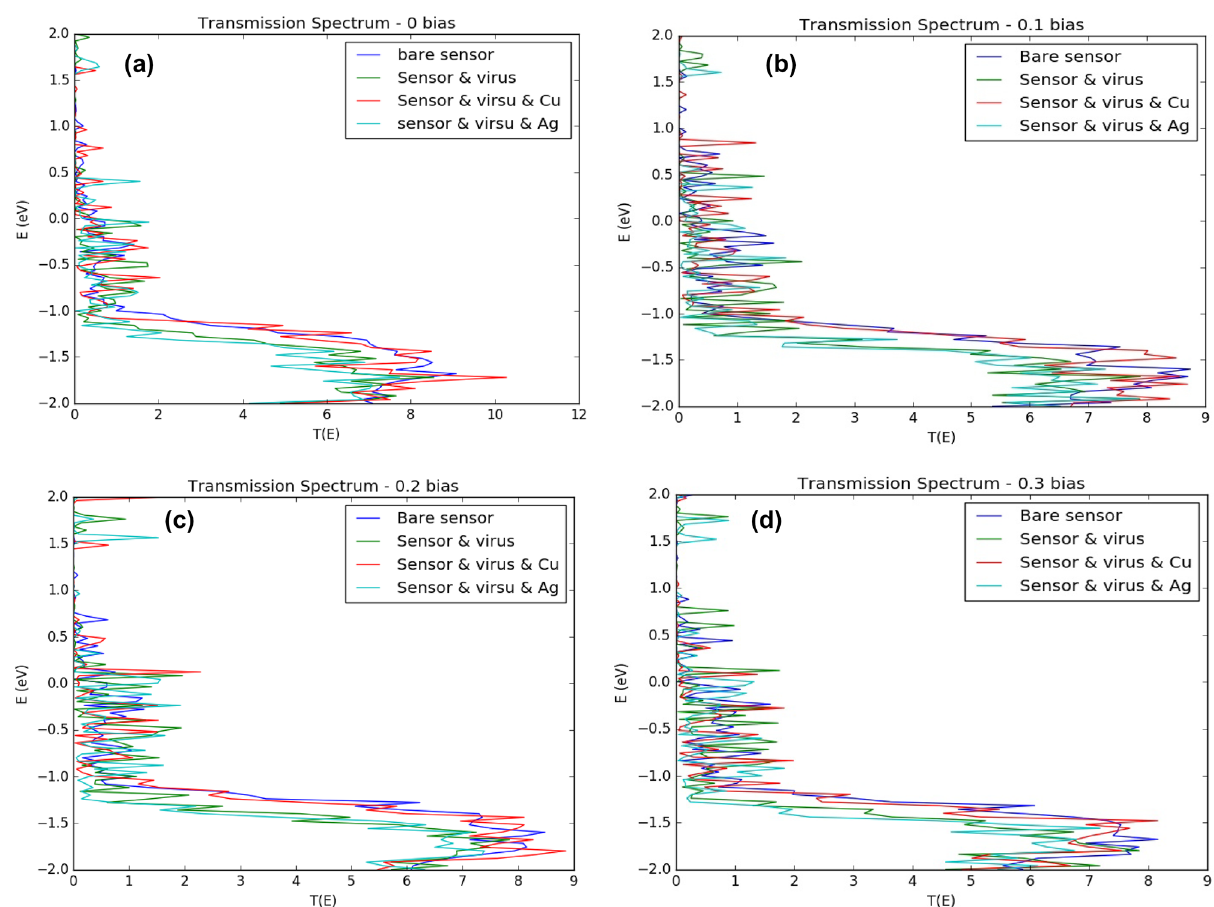
Figure 11. Transmission spectrum of the bare (without antibodies and MNP’s), virus bound, and MNPs decorated sensor at ( a ) V bias = 0.0 V ( b ) V bias = 0.1 V ( c ) V bias = 0.2 V ( d ) V bias = 0.3 V. Produced by QuantumATK software (version